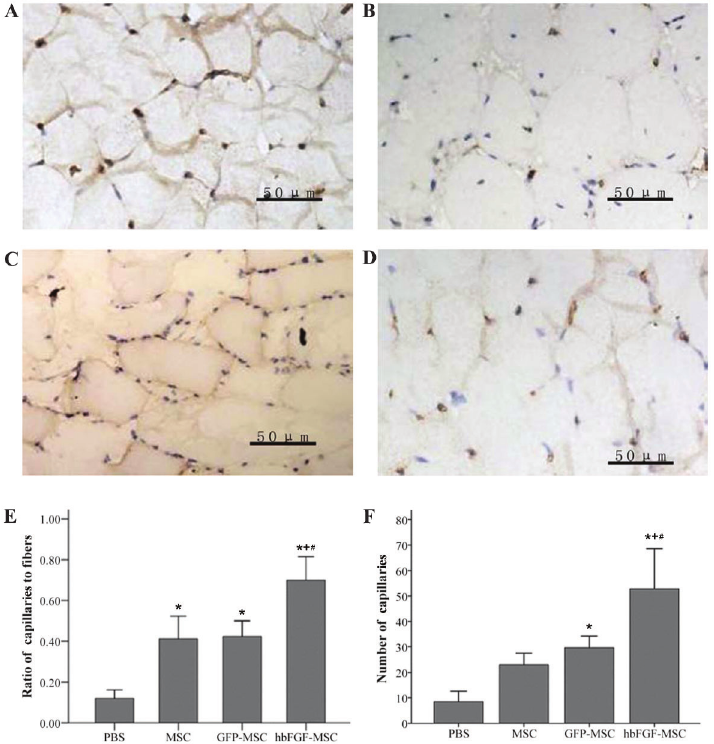
Figure 4. Overexpressing human basic fibroblast growth factor (hbFGF) in mesenchymal stem cells (MSCs) stimulates angiogenesis in a rat hind limb ischemia model. A - D , Representative images of sections of ischemic gastrocnemius muscles from the phosphate-buffered saline (PBS) control ( A ), MSC ( B ), green fluorescent protein (GFP)-MSC ( C ), and hbFGF-MSC ( D ) groups immunostained with anti-von Willebrand factor (vWF) antibodies. After counting the vWF- positive cells (microvessels) and muscle fibers, the ratio of microvessels to muscle fibers ( E ) and microvessel density ( F ) were determined. *P , 0.05, compared to the PBS group; + P , 0.05, compared to the MSC group; # P , 0.05, compared to the GFP-MSC group (n=6 for each group) (one-way ANOVA with Bonferroni post hoc